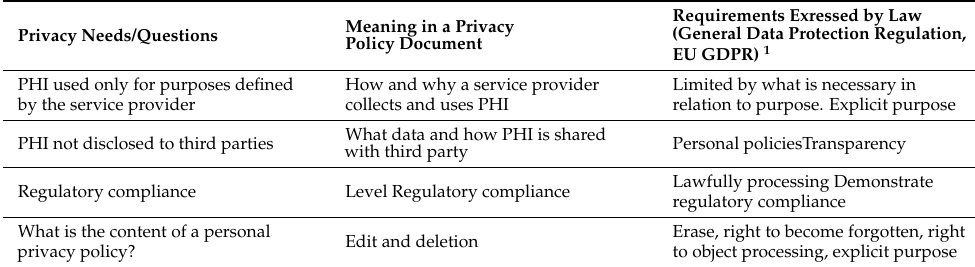
Table A1. Privacy Needs and Requirements In Policy Documents and Law from